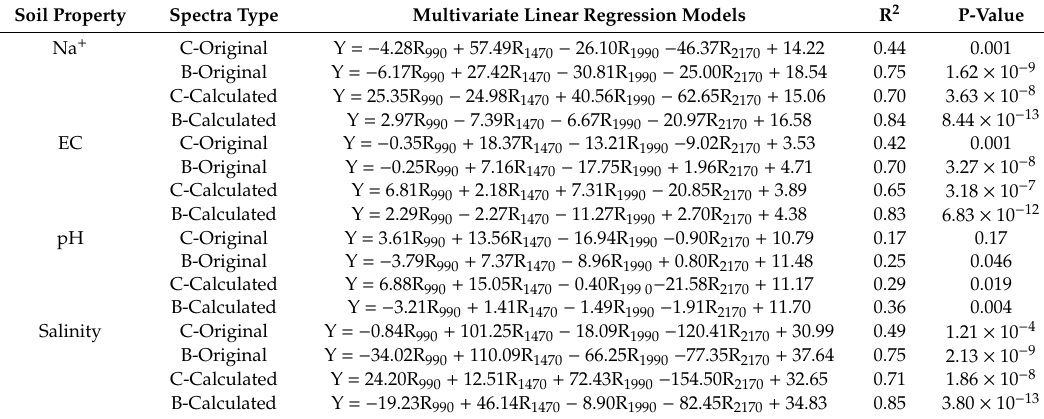
Table 3. Multivariate linear regression models for soil properties of soil